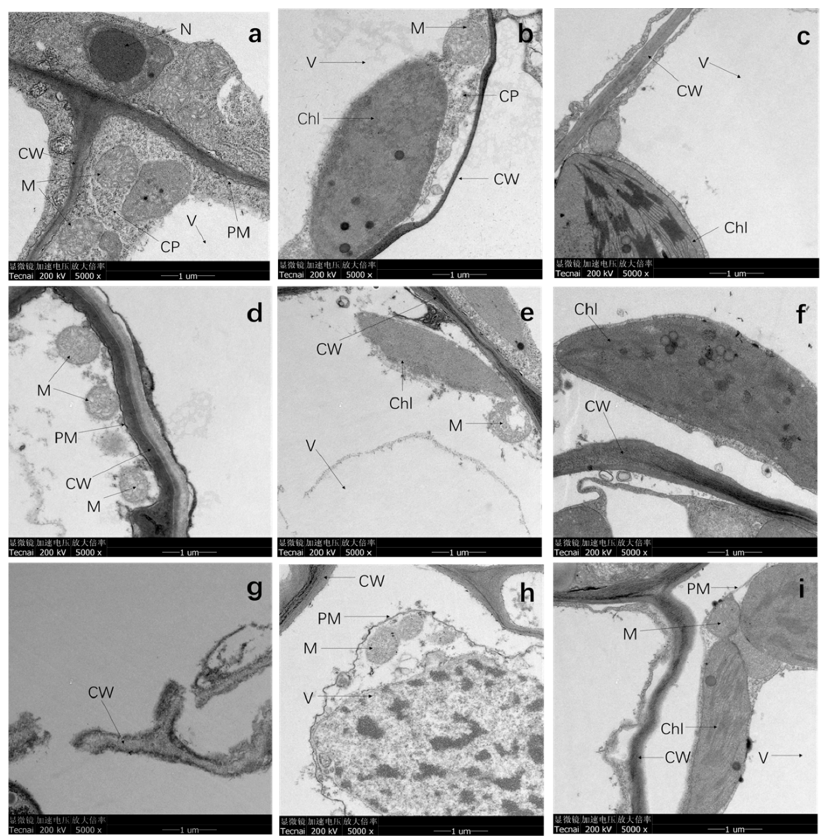
Figure 4. ( a – c ) are the root, stem, and leaf of the CK group, ( d – f ) are the root, stem, and leaf of the 10 μ M treatment group, and ( g – i ) are the root, stem, and leaf of the 100 μ M treatment group. Chl—chloroplast; CP—cytoplasm; V—vacuole; CW—cell wall; M—mitochondria; PM—cytoplasmic membrane; N—nucleus.